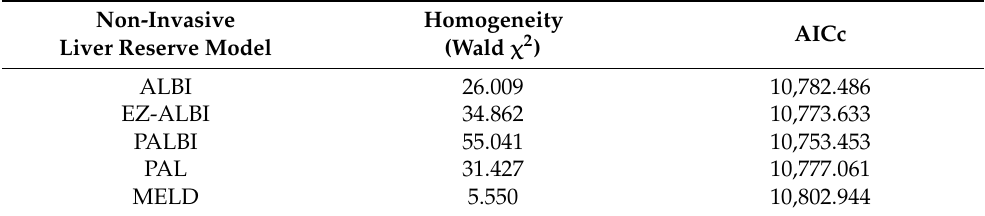
Table 8. Comparison of non-invasive liver reserve model in hepatocellular carcinoma patients undergoing transarterial chemoembolization ( n =